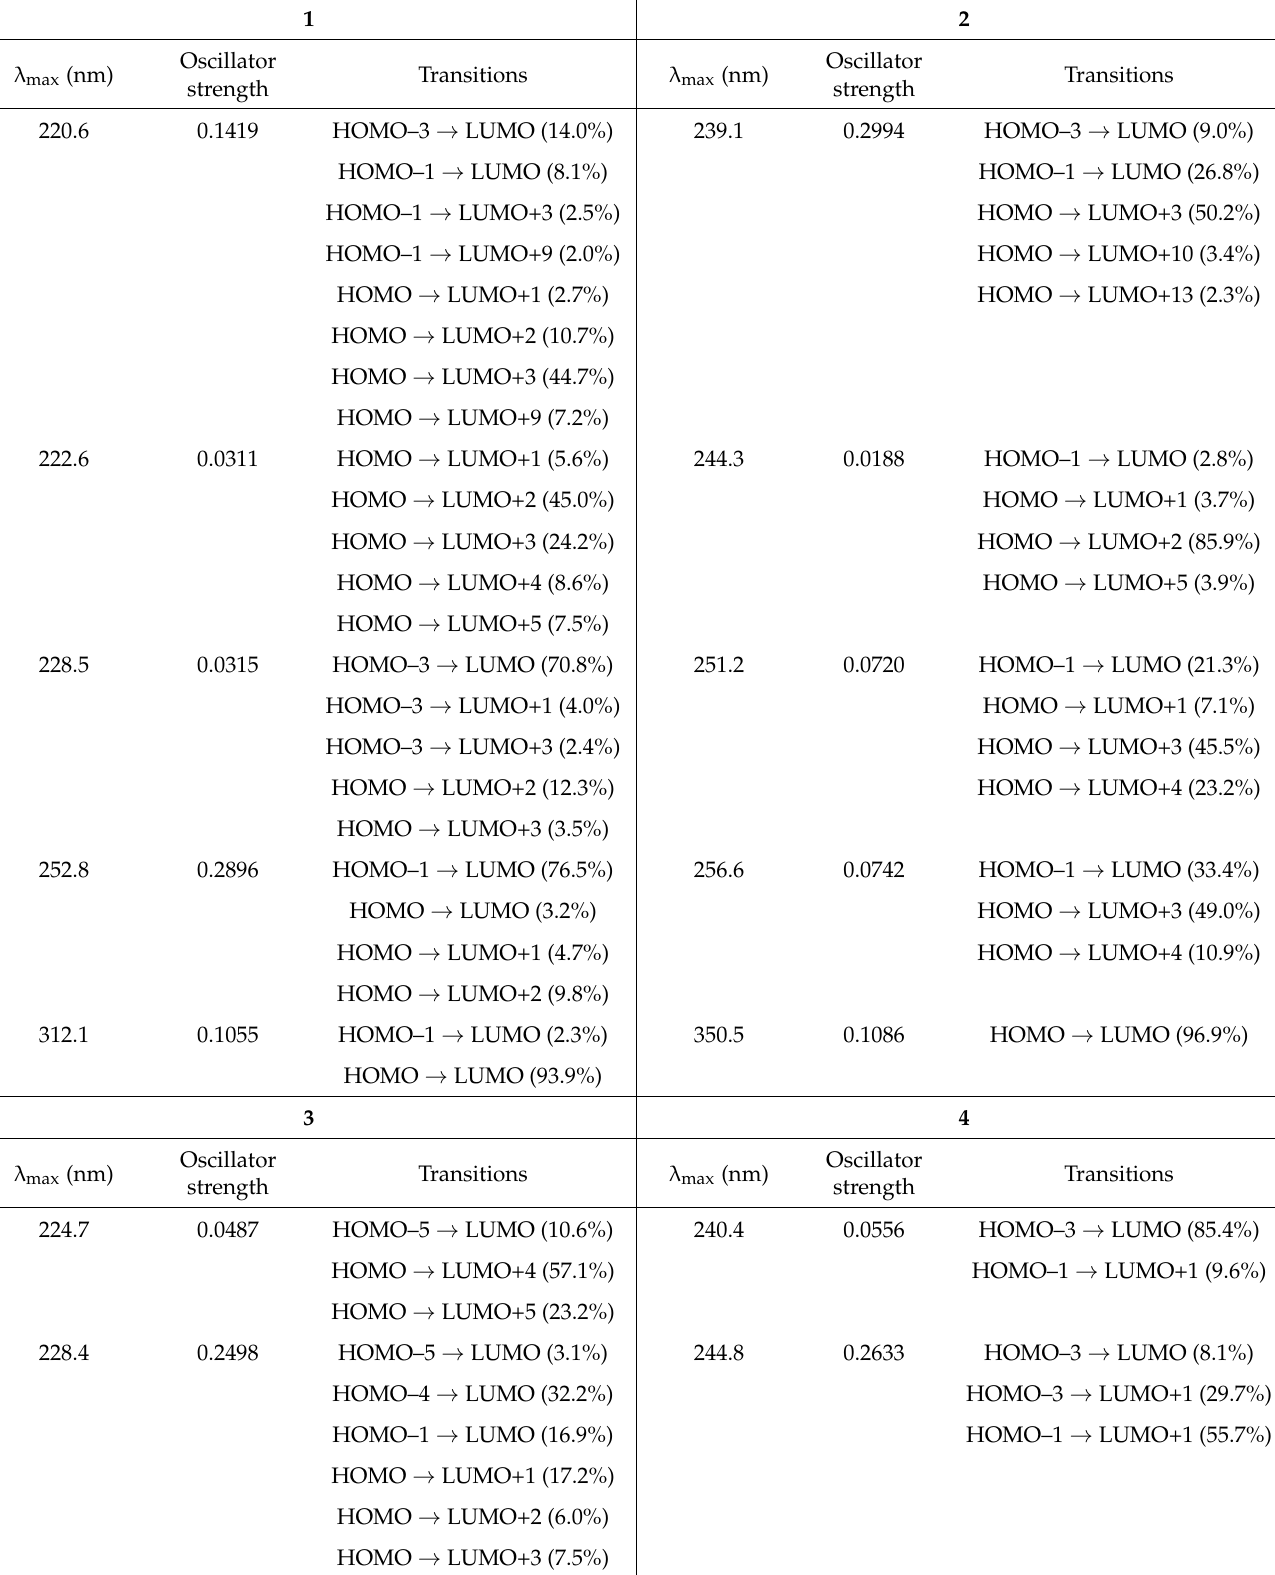
Table 4. Values for the calculated UV-vis spectra of the ground state of the enol-imine tautomers of 1 – 4 , obtained by using the TD-DFT/B3LYP/6-311++G(d,p)